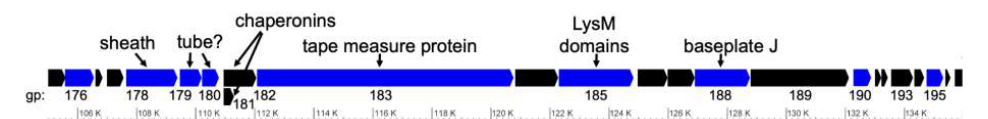
Figure 9. Phage G sheath timetree. A timetree bioinformatic analysis was conducted to analyze the evolutionary relation- ship among various phage tail sheath proteins (see Materials and Methods). The timeline unit used was 1.0 Gya. The error bars shown in purple report 95% confidence in the height of each node, and are accompanied by the posterior probability that all branches below the node are correctly placed.